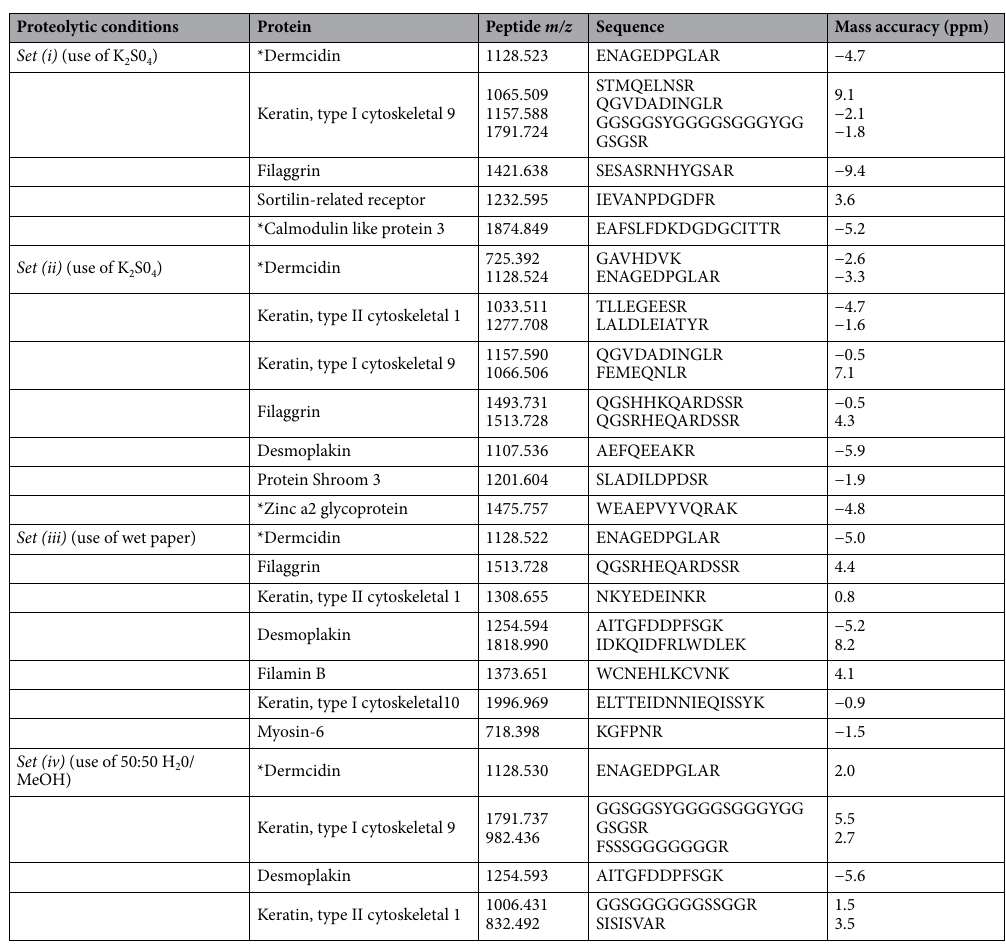
Table 2. Putative protein identification from in situ digests of ungroomed fingermarks spotted with set (i): 25 µg/mL trypsin containing 0.01% v/v glycerol and incubated in a Tupperware box containing saturated K 2 SO 4 solution at 50 °C for 2 h; set (ii) : set (i) conditions except for trypsin used at a concentration of 20 μg/mL and RapiGest SF at 0.1% replacing glycerol; set (iii) 20 μg/mL trypsin containing 0.1% RapiGest SF and incubated at 37 °C for 3 h in Tupperware box containing water-wet paper; set (iv) : same conditions as set (iii) but replacing the wet paper with 50:50 H 2 O:MeOH solution. The asterisk indicates the proteins that are reported as breast cancer biomarkers in the